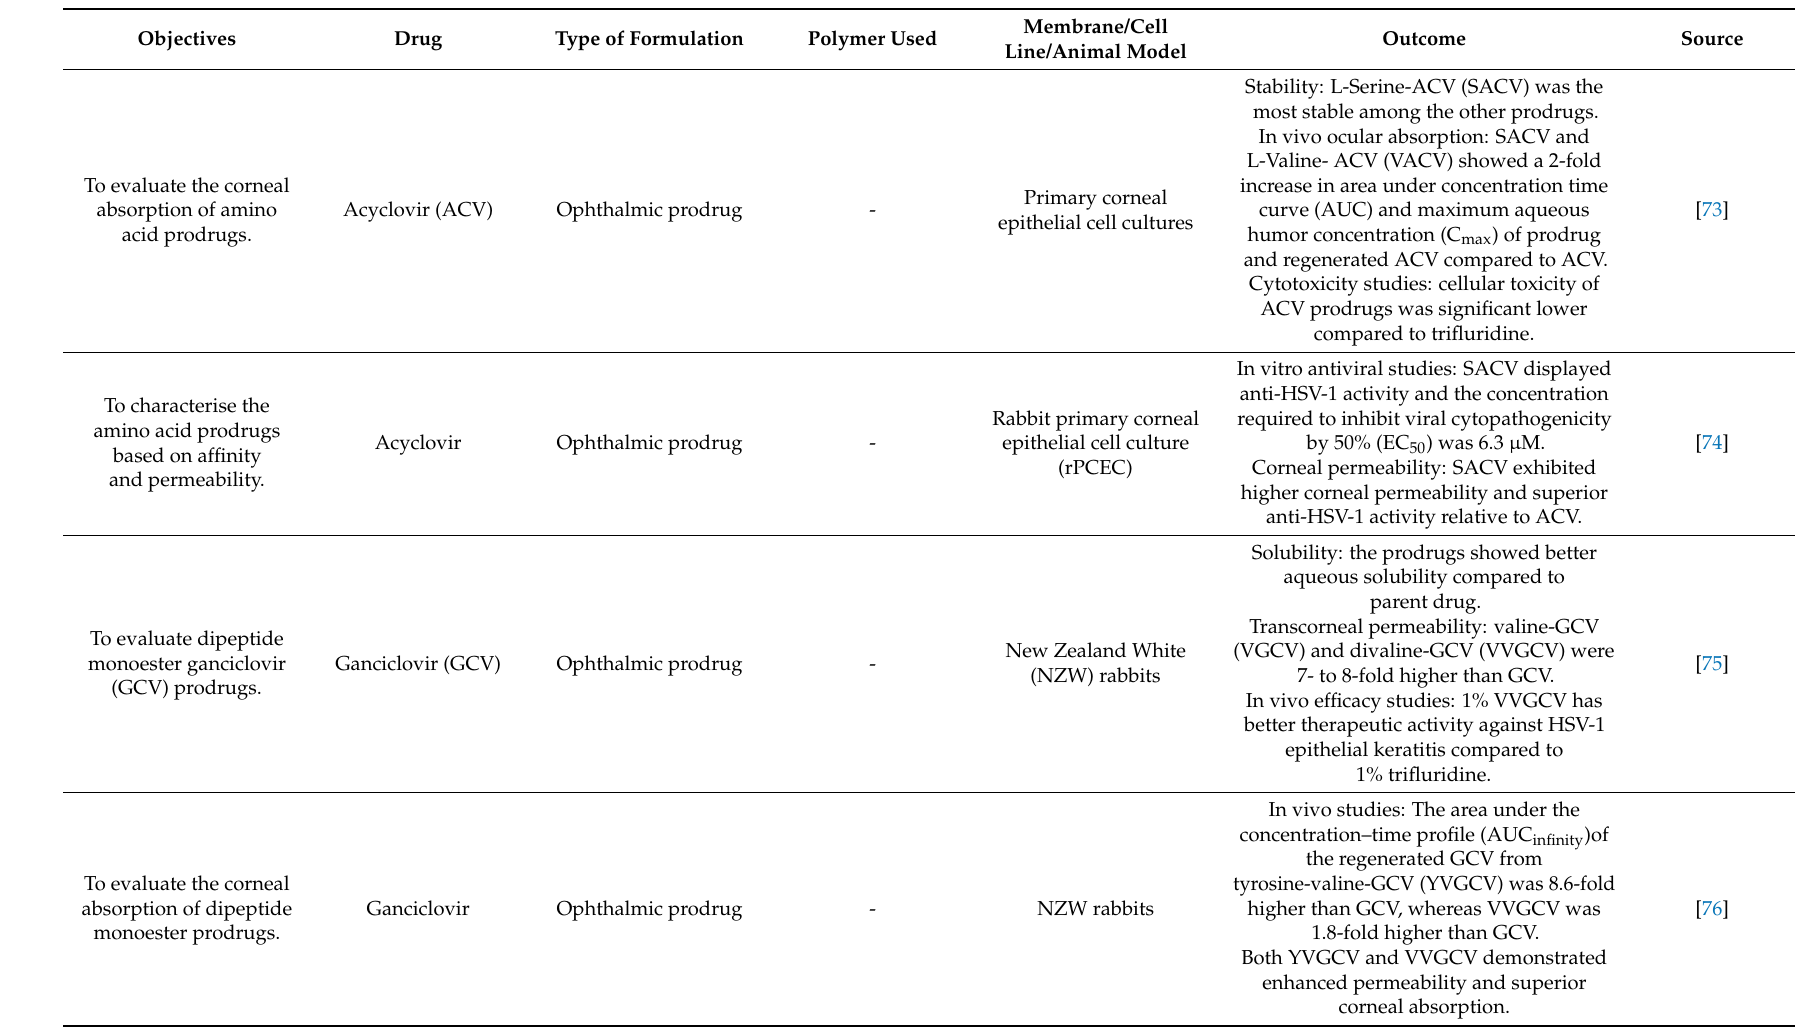
Table 3. Prodrug approach for ocular drug delivery against herpes